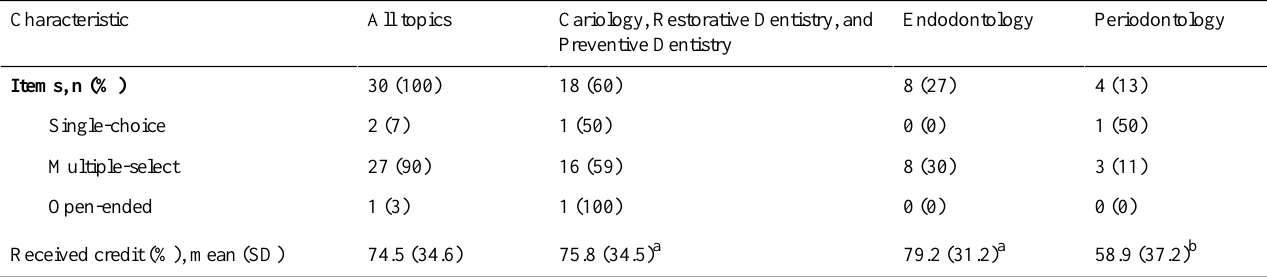
Table 2. Characteristics of multiple-choice examination items and credit awarded to examinees for each topic.